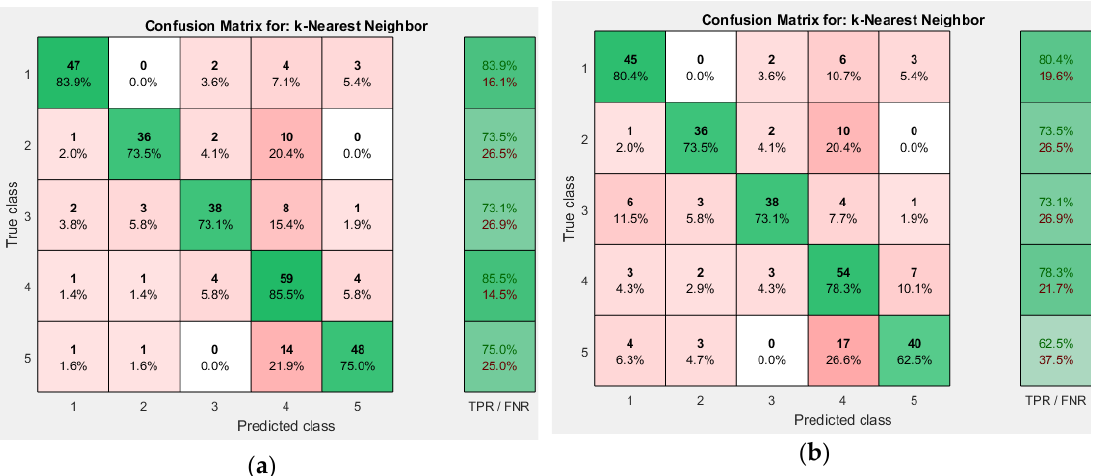
Figure 7. Confusion Matrix ( a ) Weighted KNN; ( b ) Cubic KNN.